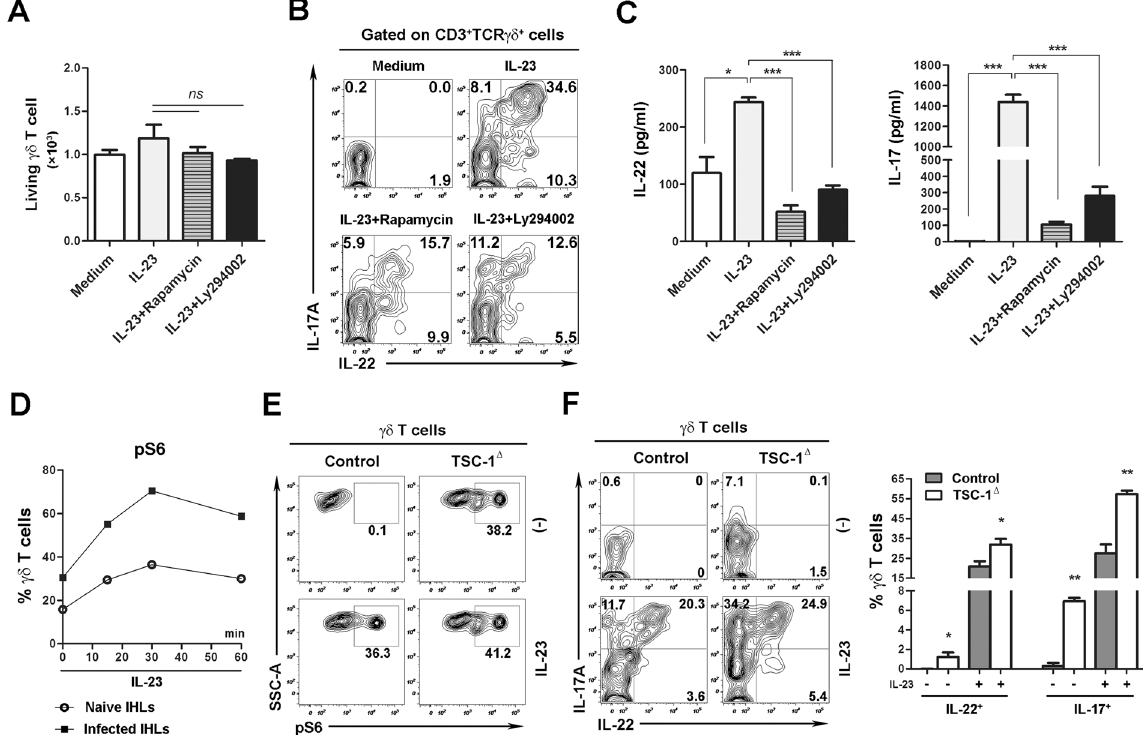
Figure 2. PI3K/mTOR pathway regulates IL-22 and IL-17 expression in virus-exposed γδ T cells. ( A to D ) IHLs were isolated from Clone 13-infected B6 mice at 3 dpi and then cultured with indicated conditions overnight. IL-23 (20 ng/ml); Rapamycin (25 nM), mTOR inhibitor; Ly294002 (5 μ M), PI3K inhibitor. ( A ) The living γδ T cells were stained with live dye and enumerated using flow cytometry. ( B ) IL-22 and IL-17A expression in γδ T cells was analyzed by flow cytometry. ( C ) IHLs were incubated with indicated conditions in vitro for 3 days, and then IL-22 and IL-17 levels in the supernatants were determined by ELISA. ( D ) IHLs of naïve or infected B6 mice were treated with IL-23 as indicated. Flow cytometry was used to detect pS6 expression in γδ T cells. ( E and F ) TSC-1-deficient (TSC-1 Δ ) or control mice were challenged with Clone 13 (2 × 10 6 pfu/mouse). IHLs were isolated at 3 dpi. ( E ) IHLs were cultured with or without IL-23 for 30 min. Expression of pS6 was examined by flow cytometry. ( F ) IHLs were cultured with or without IL-23 overnight. IL-22 and IL-17A expression in γδ T cells was detected by flow cytometry. Data are representative of three independent experiments. The results are expressed as the mean ± SEM ( n = 3–5). * p < 0.05; ** p < 0.01; *** p <